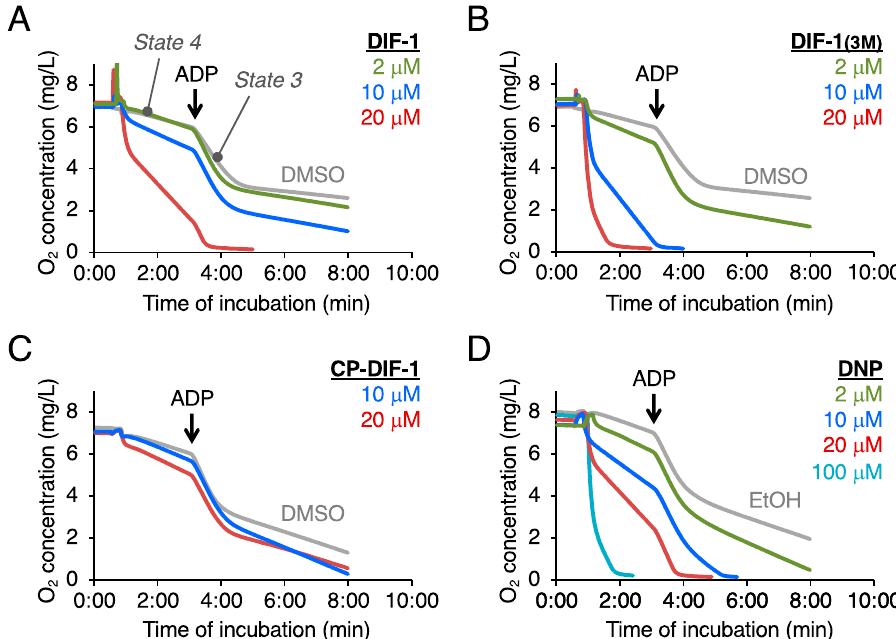
Figure 2. Effects of DIF derivatives and DNP on mitochondrial oxygen consumption (MOC) in isolated mouse liver mitochondria. MOC was monitored in the presence of 1% DMSO or EtOH (vehicles) or the indicated concentrations of DIF derivatives ( A – C ) or DNP ( D ). After recording “ State 4 ” (resting) respiration, ADP (200 µ M, final concentration) was added to induce “ State 3 ” respiration.